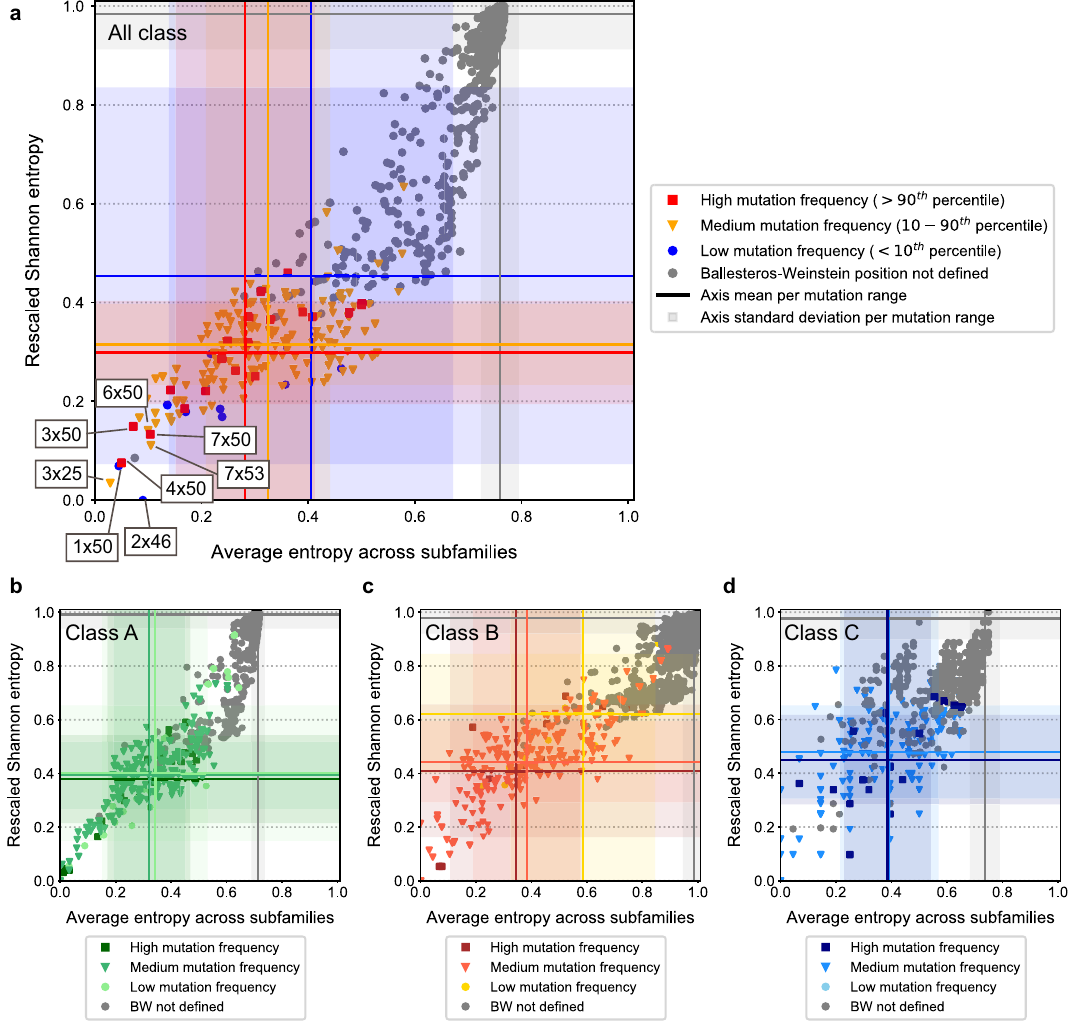
Figure 1. Shannon entropy across GPCR subfamilies versus Shannon global Entropy correlated to cancer- related mutations. A two-entropy analysis plot for all GPCRs with aligned positions. The average entropy across subfamilies (as defined by GPCRdb), i.e. conserved within a subfamily is on the x-axis, and the Shannon entropy on the y-axis. ( a ) Analysis for all GPCR classes combined. Residues are colored by the frequency of mutations found in the GDC dataset, with blue being low (< 10th percentile), orange medium (10–90th percentiles) and red high (> 90th percentile). Residues with no defined Ballesteros-Weinstein (BW) generic numbers are colored grey. Blue, orange, red, and grey lines represent the mean entropy values for each axis per mutation range (high, medium, low, and non-defined Ballesteros-Weinstein, respectively). Blue, orange, red, and grey shadows represent the standard deviation to the mean entropy values for each axis per mutation range (high, medium, low, and non-defined Ballesteros-Weinstein, respectively). ( b ) Analysis for Class A GPCRs. ( c ) Analysis for Class B GPCRs. ( d ) Analysis for Class C GPCRs. The coloring scheme for panels ( b )–( d ) is equivalent to that of panel ( a across families (Fig. 1 and Supplementary Table S1). In the all-class TEA (Fig. 1a), the low mutation range had mean entropy values of 0.45 ± 0.38 and 0.41 ± 0.27 (Shannon and Average entropy across families, respectively). The high mutation range had lower mean entropy values of 0.30 ± 0.10 and 0.28 ± 0.13, respectively. On the contrary, this trend was not observed on natural variance data from the 1000 Genomes dataset (Supplementary Fig. S2). There, mean entropy values for the low mutation range were 0.40 ± 0.30 and 0.33 ± 0.23, respectively; and 0.34 ± 0.08 and 0.39 ± 0.12, respectively, for the high mutation range. We observed an average downward shift in entropy values for highly mutated positions per subfamily (not in the overall Shannon entropy) and an upward shift for less frequently mutated positions. Combined this showed a pressure in the GDC data for muta- tions in subfamily-conserved positions at the expense of mutations in non-conserved positions. This trend was maintained across classes, although less marked for for Classes B and C, and supported by the fact that from the type Q3 residues highlighted in Fig. 1a, higher mutation frequencies were associated with the most conserved positions in TM domains 3, 4, and 7 (i.e. 3 × 50, 4 × 50, and 7 × 50). These are part of the “DRY” (TM3), “GWGxP”